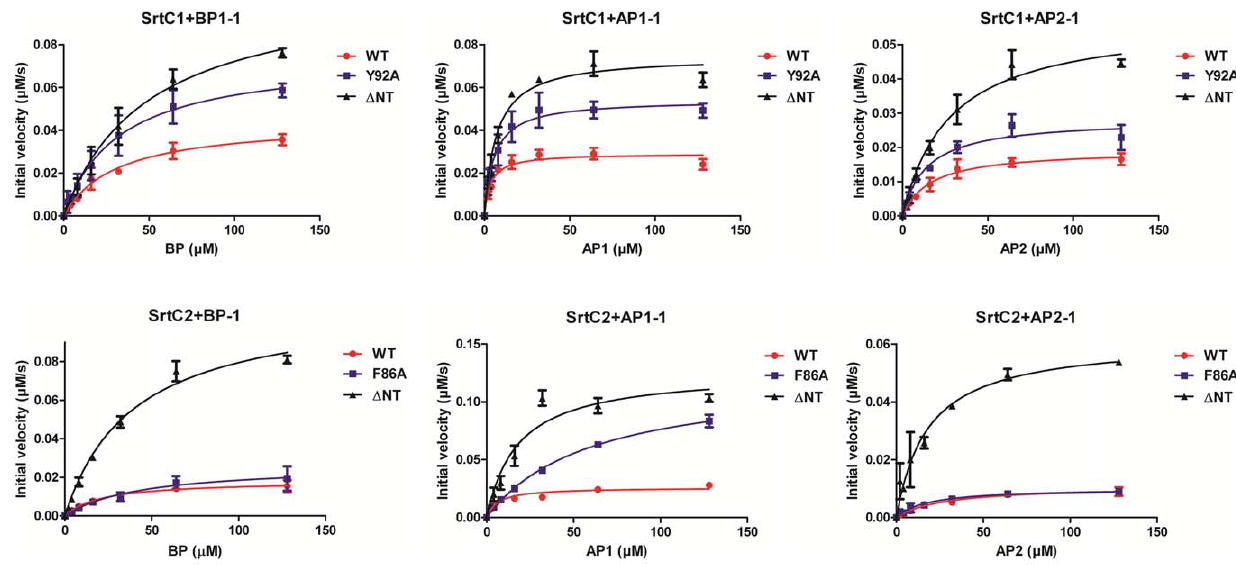
Figure 6. Kinetic analysis of PI-1 SrtC1 and SrtC2 wild-type and mutants. Triplicate data sets for each experiment were used to calculate the steady-state velocity at different PI-1 peptides concentrations for each enzyme and were expressed as initial rates ( m M/s) versus concentration of substrate. SrtC1 (top) and SrtC2 (bottom) enzymes carrying the mutation Y92A and F86A (SrtC1 Y92A and SrtC2 F86A ) and the deletion of the entire N- terminal region (SrtC1 D NT and SrtC2 D NT ) were analyzed in comparison with wild-type enzymes by FRET assays at various concentrations of three different PI-1 peptides (Table 2). The reactions containing 25 m M of enzyme and 2–128 m M of fluorescent peptide were performed at 37 u C in 20 mM HEPES pH 7.5, 100 mM NaCl and 1 mM